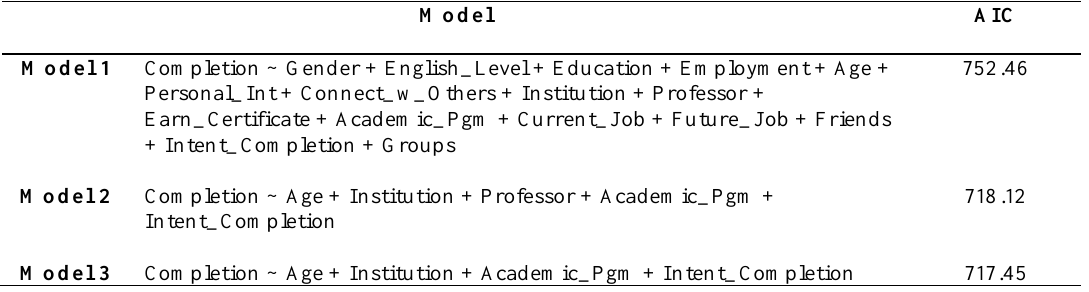
AIC Comparison Among Models